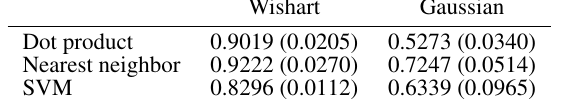
Table 1. Comparison of results on the FL image.